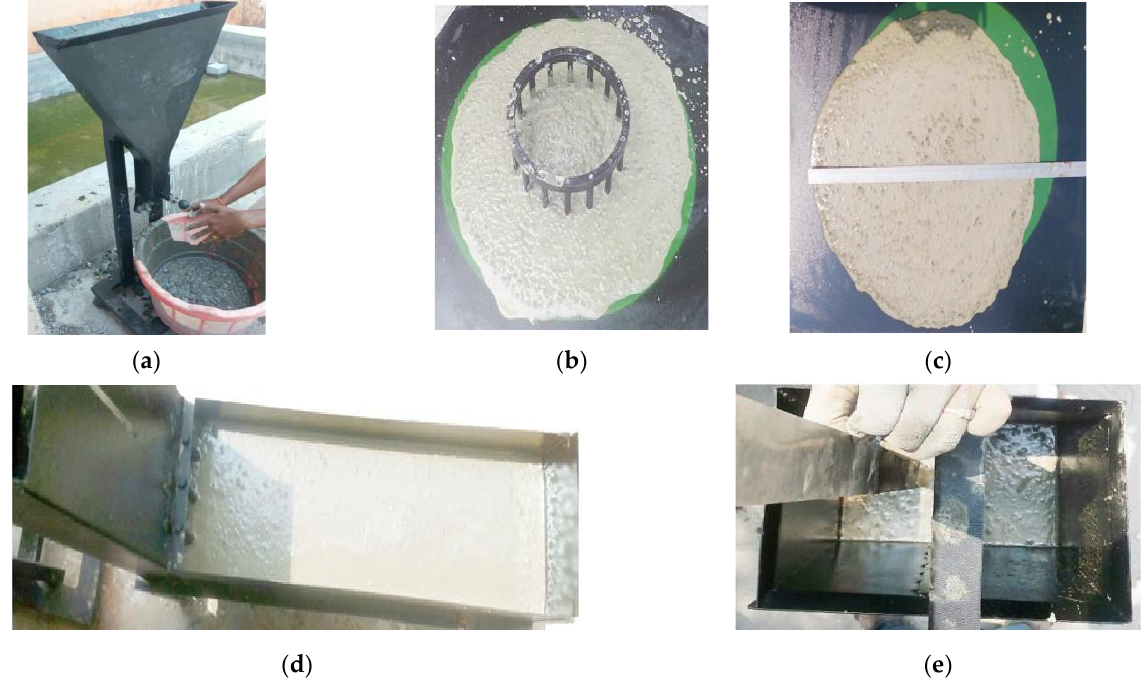
Figure 4. Tests on self-compacting concrete mixes. ( a ) V-funnel test. ( b ) J-ring test. ( c ) Slumpflow test. ( d ) L-box test. ( e ) U-box test.